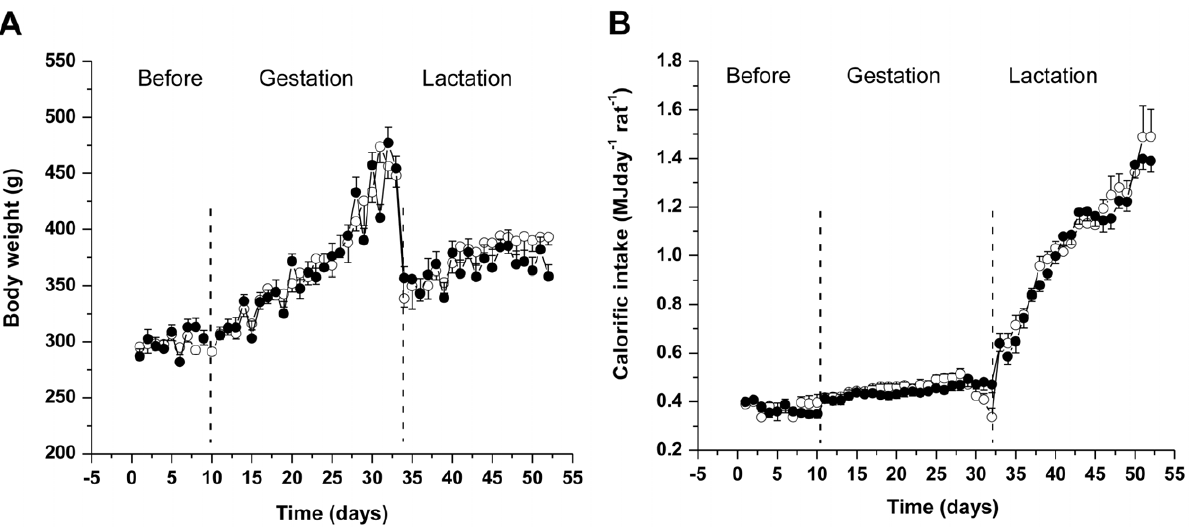
Figure 1. Control and fat-fed dams had a similar body weight gain and calorific intake. (A) Body weight, g, and (B) calorific intake, MJ rat 2 1 day 2 1 , in dams fed a control (open circles) or a fat diet (closed circles), n=11 for control, n=16 for fat-fed dams. Error bars represent mean 6 SEM.